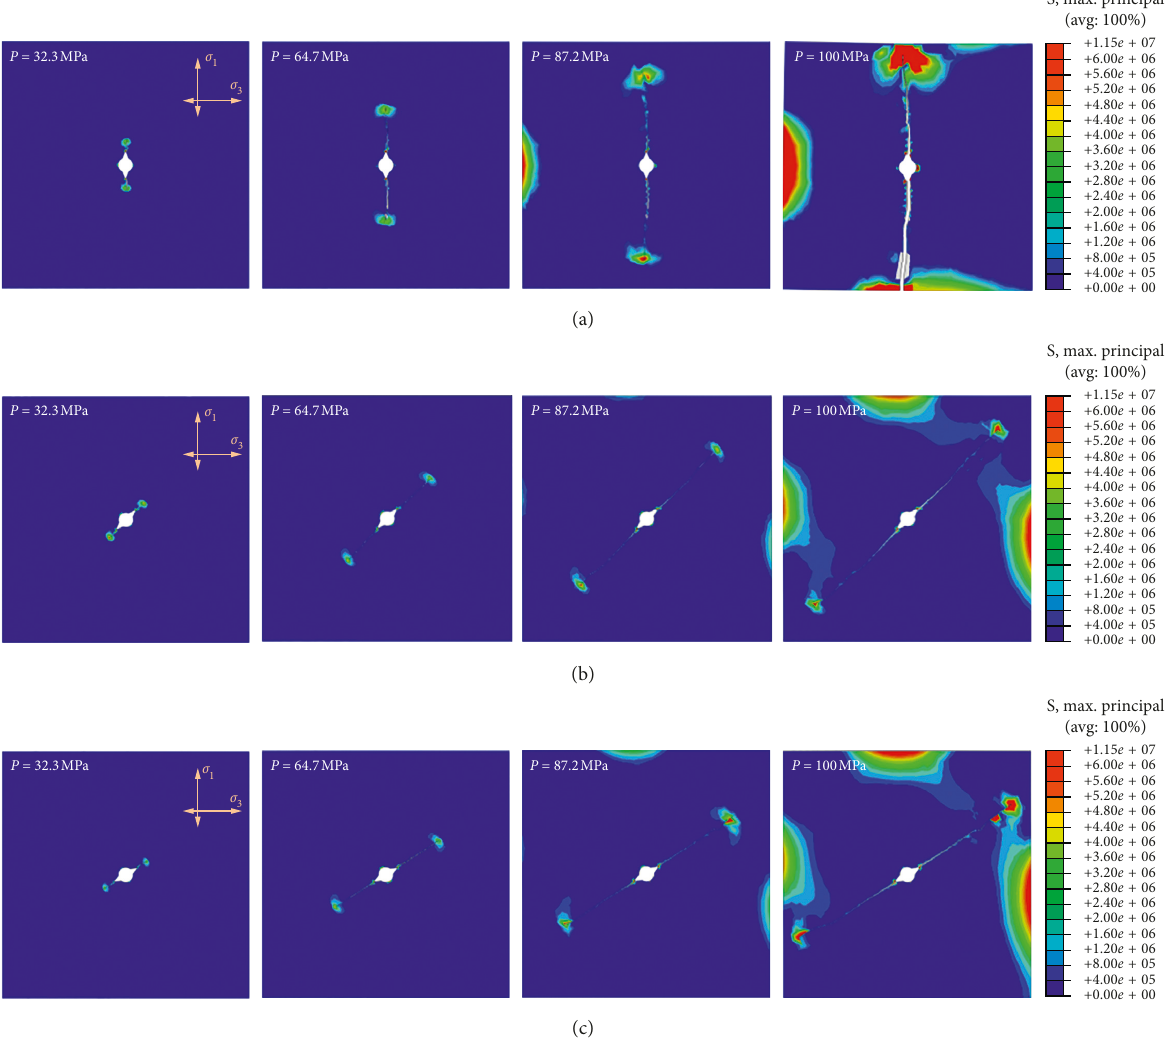
Figure 13: Crack characteristics under σ expansion